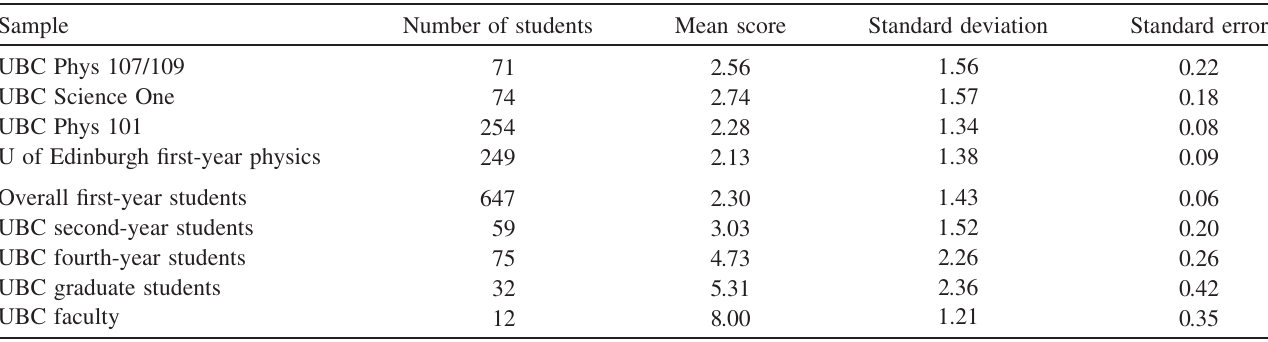
TABLE I. Pre-test results.